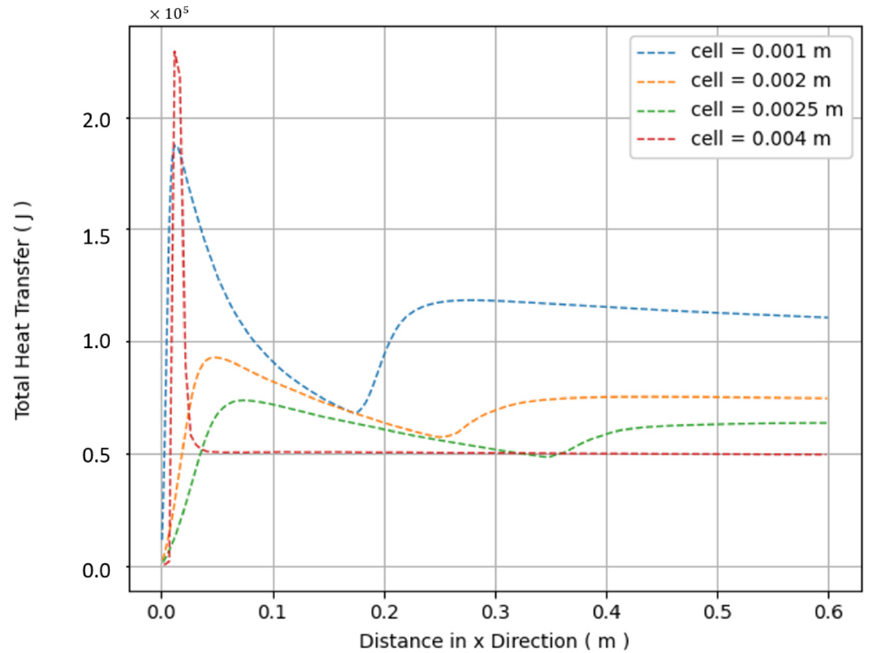
Figure 2. Grid convergence study of general cell size.